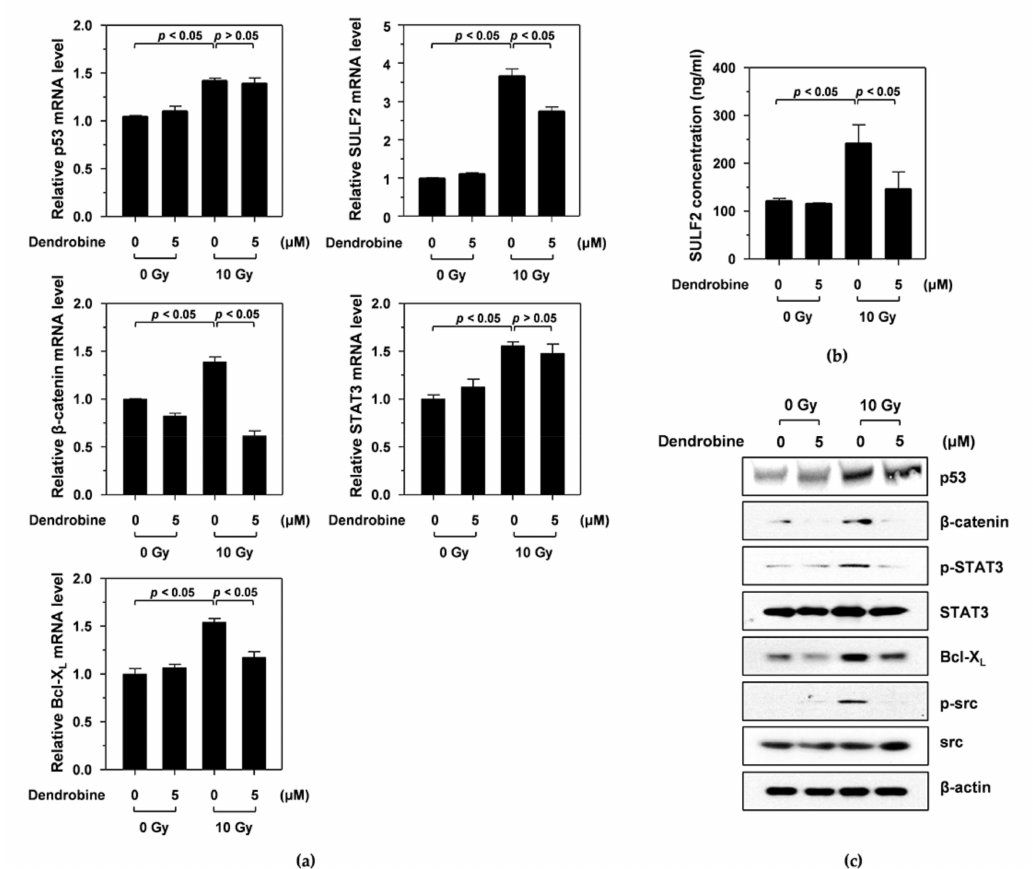
Figure 3. Inhibitory effect of dendrobine on IR-induced signaling, by inhibiting the mRNA and protein expression of SULF2. ( a ) mRNA levels of IR-induced signaling molecules, including p53, SULF2, β -catenin, STAT3, and Bcl-X L , were measured using qRT-PCR. ( b ) SULF2 protein expression was determined using an ELISA kit. ( c ) Protein expression levels of p53, β -catenin, phosphorylated STAT3, STAT3, Bcl-X L , phosphorylated Src, and Src were measured using Western